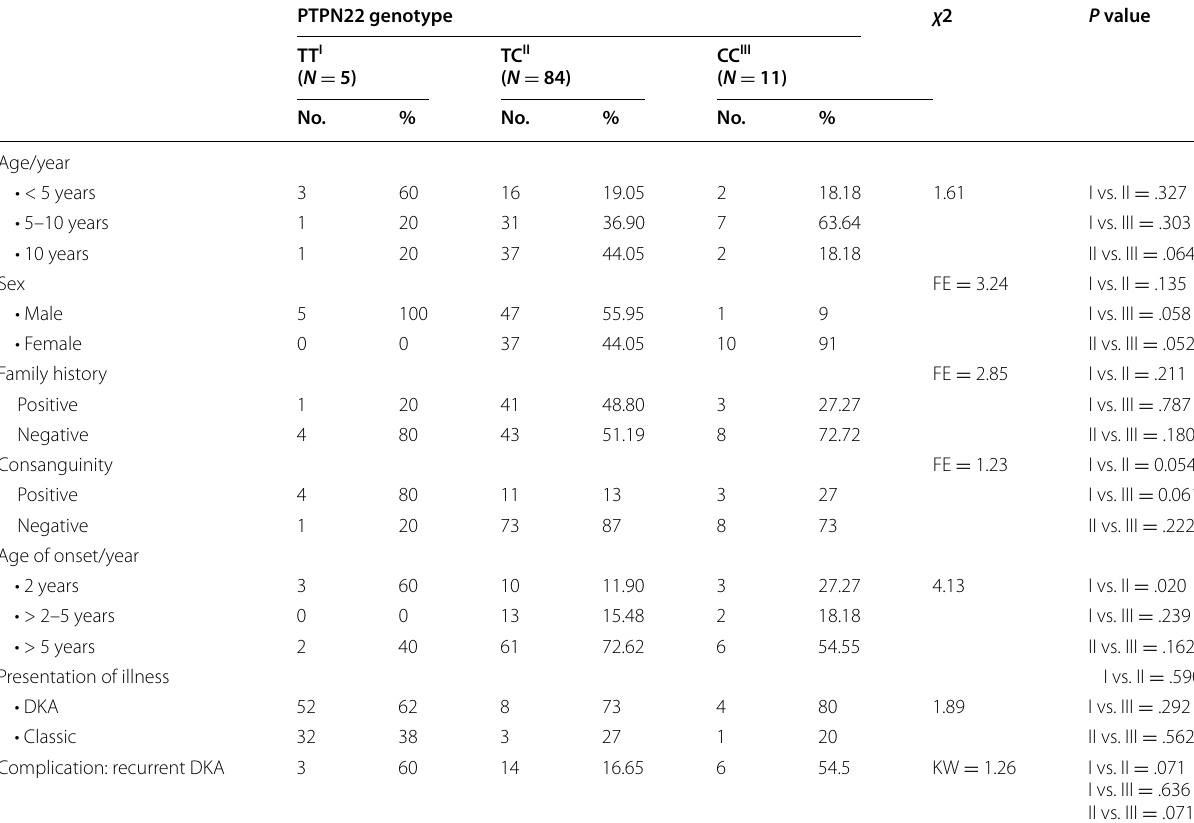
Table 3 Relation between different PTPN22 genotypes and patients’ demographics and clinical data